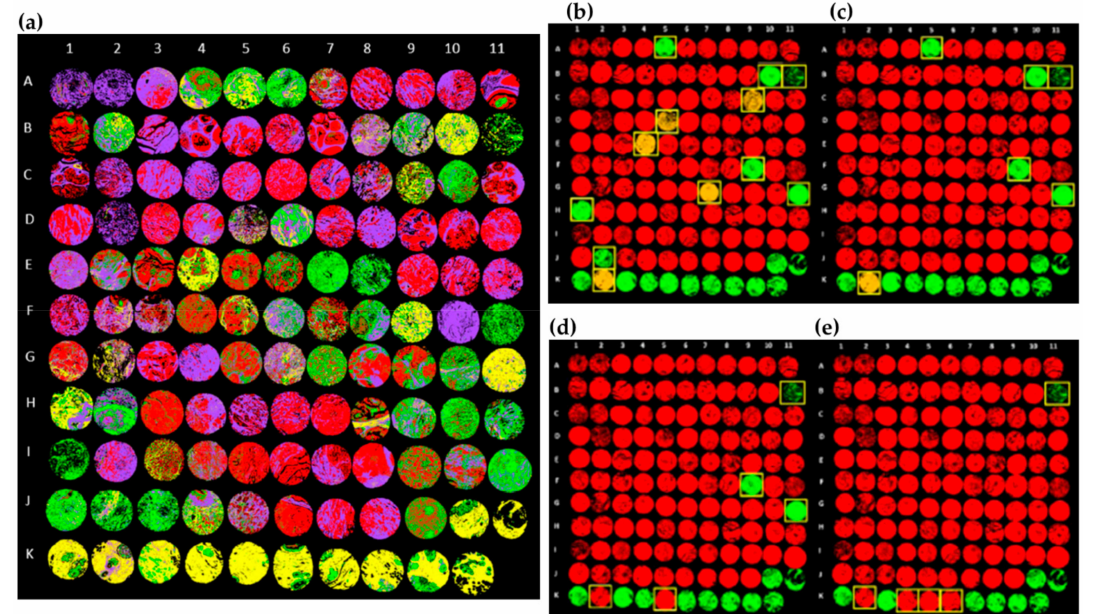
Figure 11. ( a ) False-coloured images of 120 grade II breast cancer cores: red—cancerous epithelium, purple—cancerous stroma, green—normal associated epithelium and yellow—normal associated stroma; ( b – e ) false-coloured images of 120 grade II breast cancer cores using a traffic light system with a threshold of: ( b ) 0.5, ( c ) 0.3, ( d ) 0.2, ( e ) 0.1, where red represents cancerous cores, green represents normal cores and amber represents cores that could not be classified as either cancerous or normal, and therefore should be looked at by a pathologist. The yellow boxes indicate cores which were wrongly classified [167]. Alterations made to original Figure 5: ( c , d ) placed parallel to ( a , b